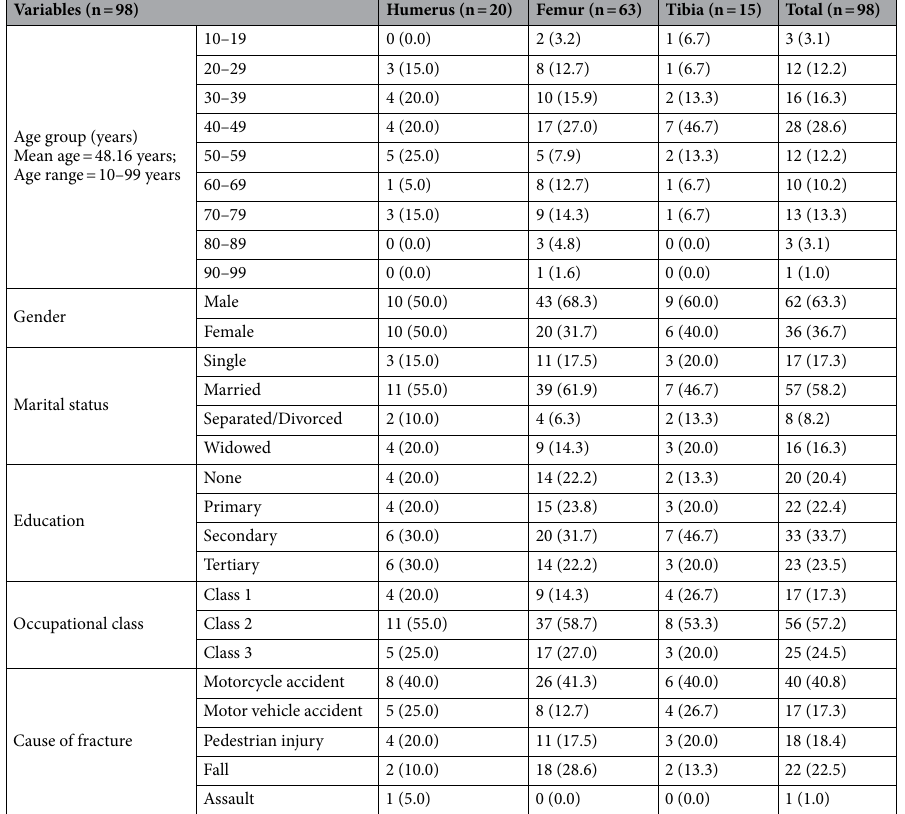
Table 1. Patients’ sociodemographic characteristics and cause of